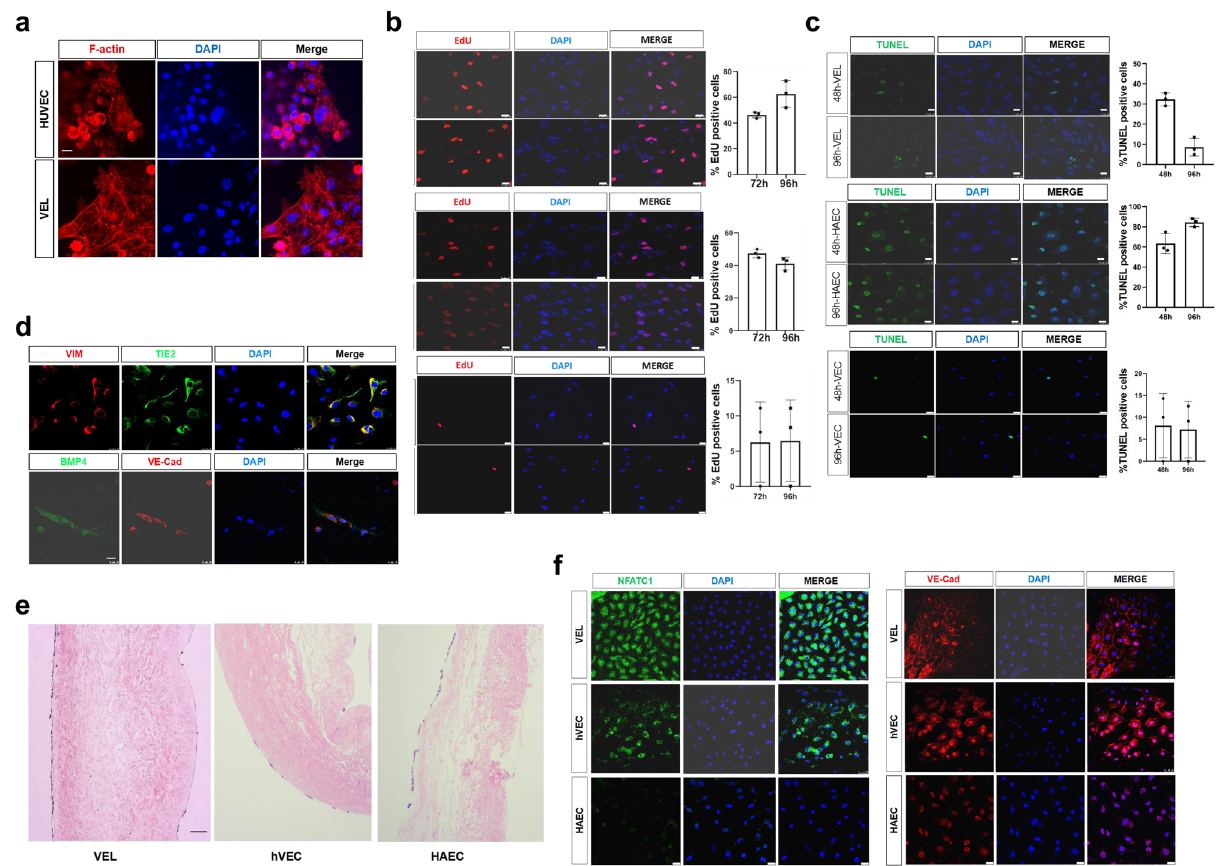
Fig. 8 Endothelialization of de-cellularized porcine heart valves by hPSC-derived VELs. a IF staining of F-actin showing the morphology of hPSC-derived VECs and HUVEC seeded onto the de-cellularized porcine heart valves. Scale bar: 25 μ m. b Left panel: EdU staining results for hPSC-derived VELs, the primary VECs from 15-year old and HAEC that have been seeded onto the de-cellularized porcine heart valves for 72 and 96 h. Right panel: bar graphs showing the percentage of EdU positive cells for left panel. Bar: 25 μ m. c Left panel: TUNEL assay for hPSC-derived VELs, the primary VECs and HAEC that have been seeded onto the de-cellularized porcine heart valves for 48 and 96 h. Right panel: bar graphs showing the percentage of TUNEL positive cells for left panel. Bar: 25 μ m. d IF staining images showing BMP4/VE-Cad and VIM/TIE2 double positive signals in hPSC-derived VELs seeded onto the surface of the de-cellularized porcine heart valves. Bar: 50 μ m. e HE staining showing the lining of hPSC-derived VELs at the surface of DCVs after 2 – 3 weeks of co- culturing. Lateral view of the representative DCVs. Left: the aortic side of the valve; Right: the ventricular side of the valve. Bar: 100 μ m. f IF staining images showing NFATc1 and VE-cad signals in hPSC-derived VELs, the primary VECs and HAEC that have been seeded on the surface of de-cellularized porcine heart valves for 2 – 3 weeks. Scale bar: 100 μ m. All experiments were repeated three times. Shown are representative images in ( a – f